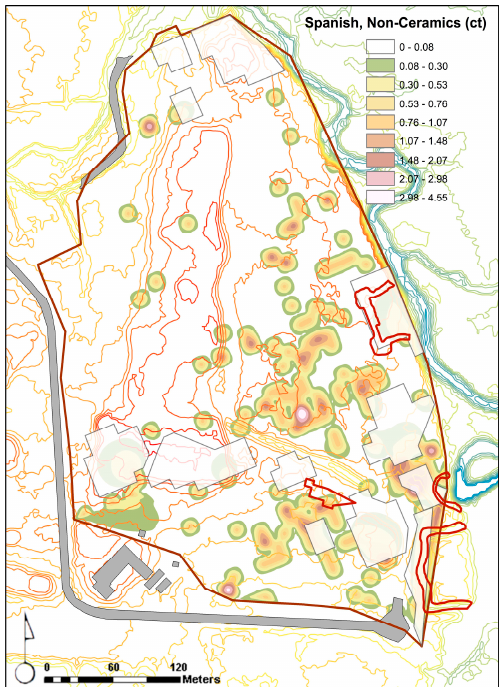
Figure 12. The distribution of Spanish period non-ceramic materials recorded through a shovel test survey. Areas whited-out were not shovel tested. Contour spacing is 1 m. Contours are based on the LiDAR dataset and use the NAD 1983 and NAV 1988 horizontal and vertical datum, respectively.